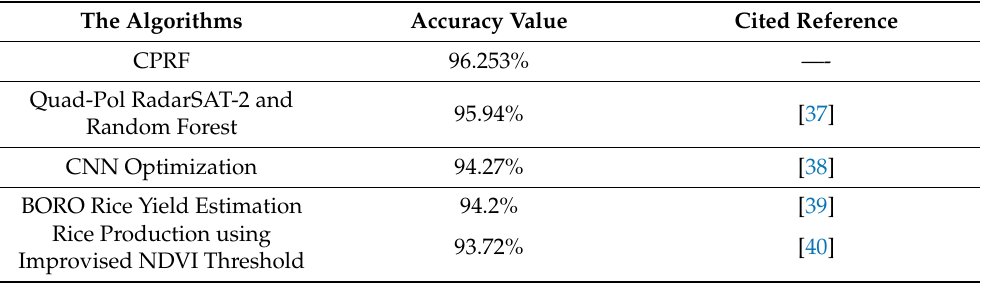
Table 4. Comparison of paper with cited